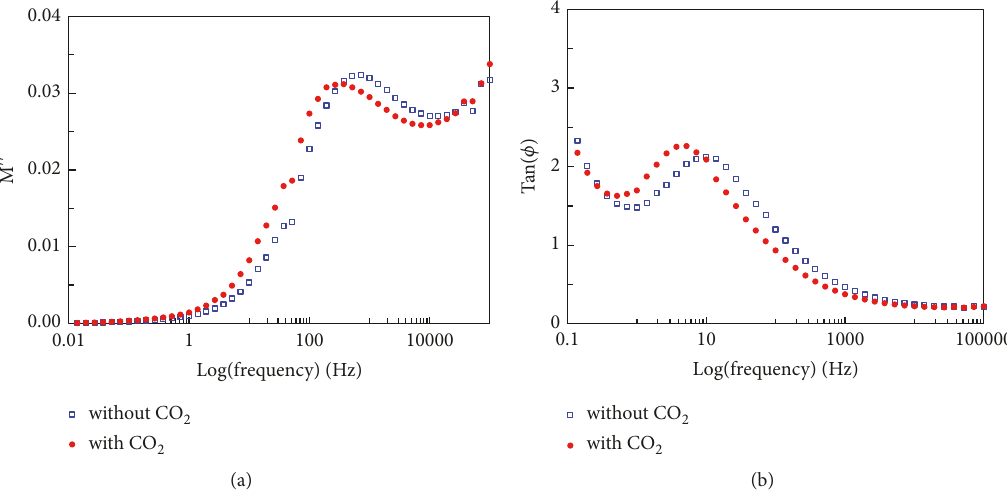
Figure 10: (a) Modulus loss M 󸀠󸀠 and (b) loss tangent graphs with and without CO 2 of Z5A-2 at 373